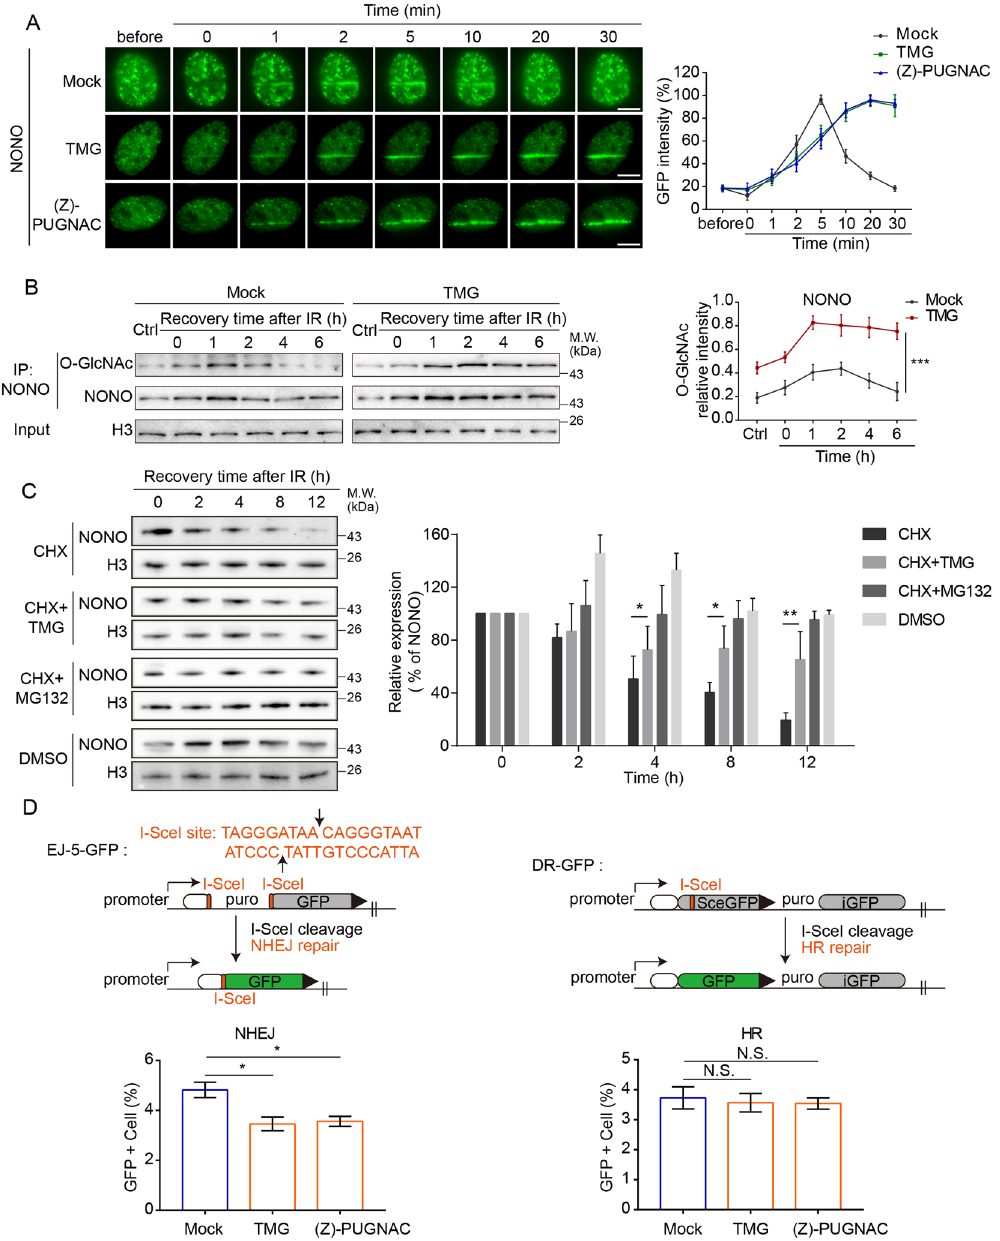
Fig. 5 Deglycosylation of NONO regulates its chromatin association and NHEJ repair. A The OGA inhibitors ’ treatment prolongs the retention of NONO at DNA lesions. GFP-NONO was expressed in U2OS cells, and the cells were treated with TMG or (Z)-PUGNAC followed by laser microirradiation. The relocation kinetics of NONO was examined in a time course. Scale bar: 5 μ m. B TMG treatment prolongs the retention of NONO on chromatin during DNA damage response. 293T cells were treated with TMG followed by IR. The chromatin fractions were extracted. O-GlcNAcylation of NONO was examined in a time course with Western blotting. C TMG treatment suppresses the removal of NONO from the chromatin. 293T cells were treated with cycloheximide (CHX: 100 μ M) or CHX and TMG (10 μ M), and then collected at different time points. The chromatin fractions were examined with Western blotting. D The role of OGA in the NHEJ and HR repair pathway. GFP reporter assays were used to examine NHEJ and HR. Stable reporter cell lines were used to monitor either NHEJ or HR repair. Each of these cell lines has an integrated cassette comprising an I-SceI cleavage site, upon repair by either NHEJ or HR, restores GFP expression. Cells with mock or OGA inhibitors (TMG or (Z)-PUGNAC) treatment were assessed for each repair mechanism as indicated by the percentage of cells that express